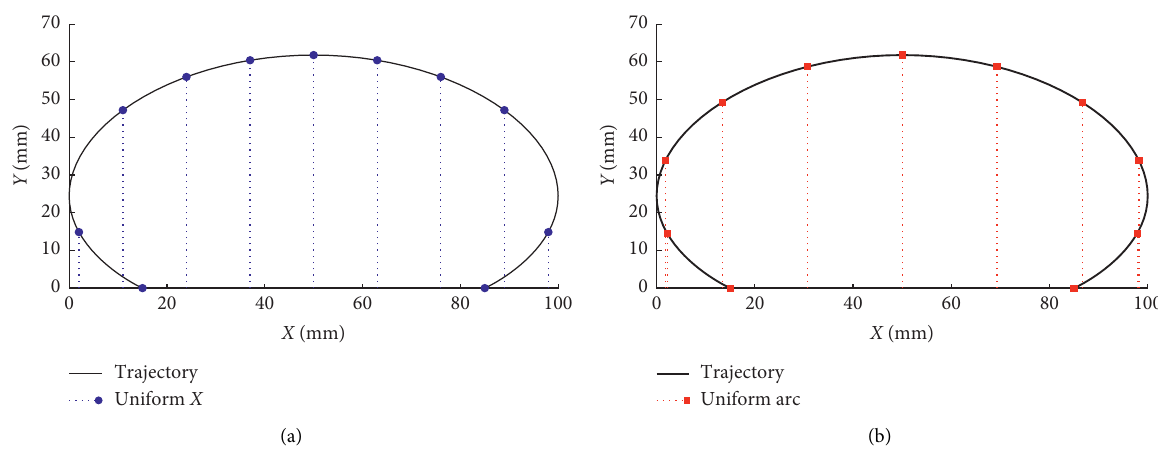
Figure 8: Spatial domain trajectory divisions. (a) Uniform X. (b) Uniform arc. Table 3: Corresponding trajectory points of uniform X .